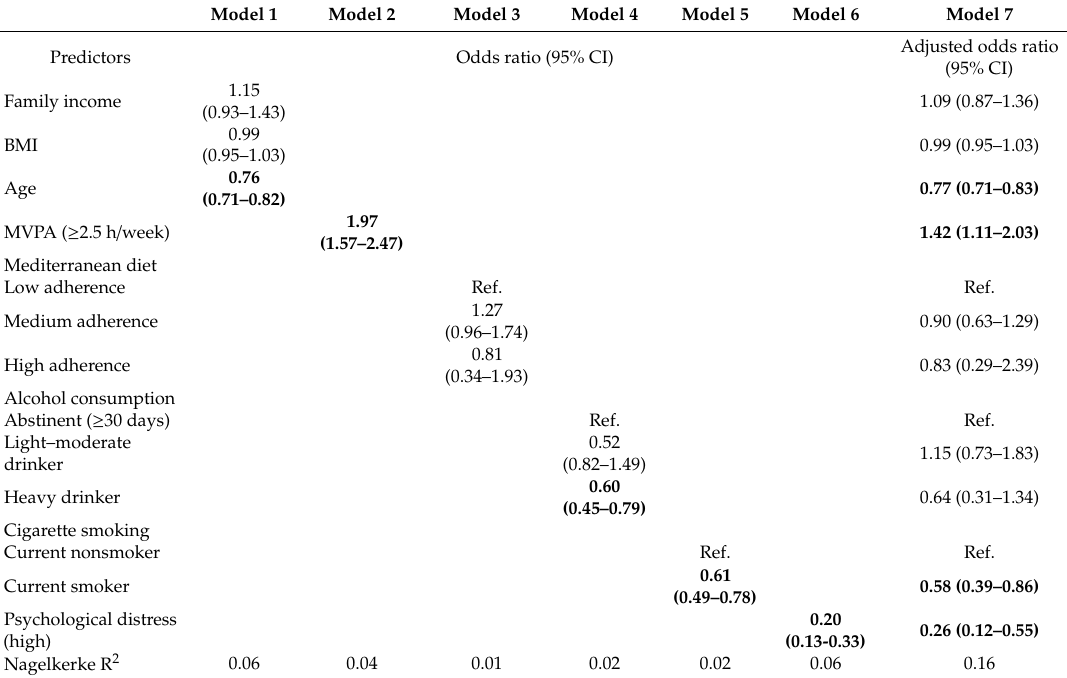
Table 3. Multiple logistic regression predicting enlistment to military service from health behaviors and distress in Lithuanian male youth, controlling for family income, body mass index, and age (crude and adjusted odds ratios